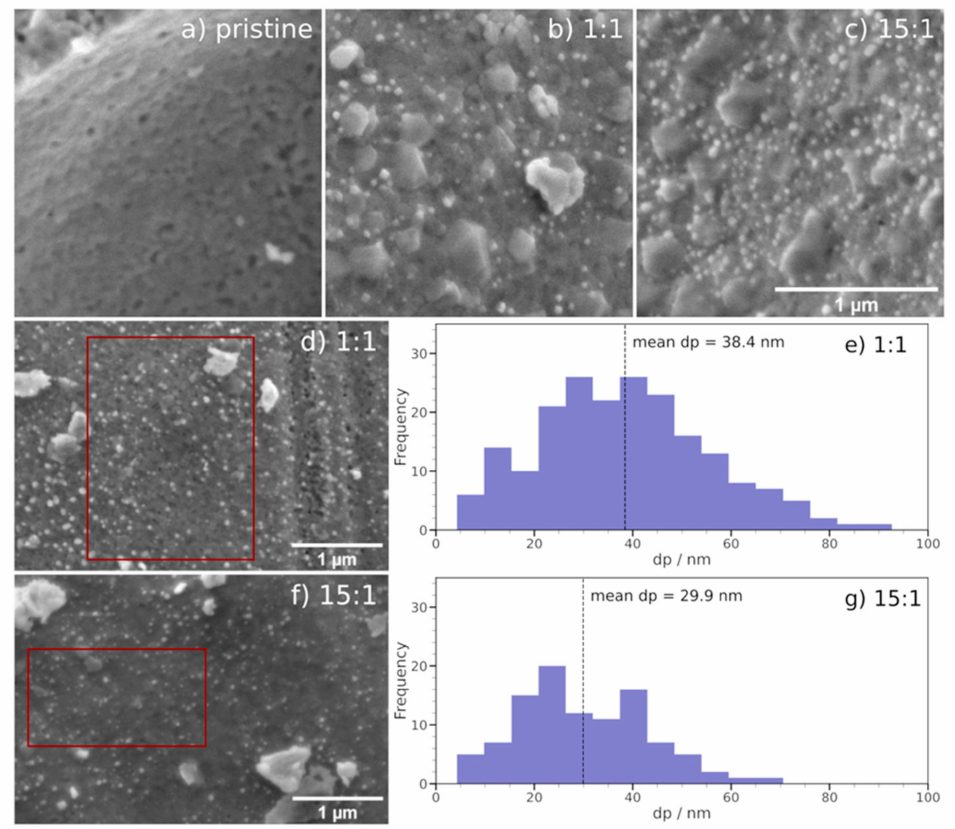
Figure 3. SEM images of Nd 0.6 Ca 0.4 Fe 0.9 Co 0.1 O 3- δ : ( a ) pristine perovskite after calcination; ( b , d ) after reaction using a CO 2 to H 2 ratio of 1:1; ( c , f ) after reaction using a CO 2 to H 2 ratio of 15:1. After both experiments, nanoparticle formation could be observed. In ( b , c ), CaCO 3 formation can be seen. For the marked areas in ( d , f ), particle analyses were performed with the results being shown as histograms in ( e , g ),